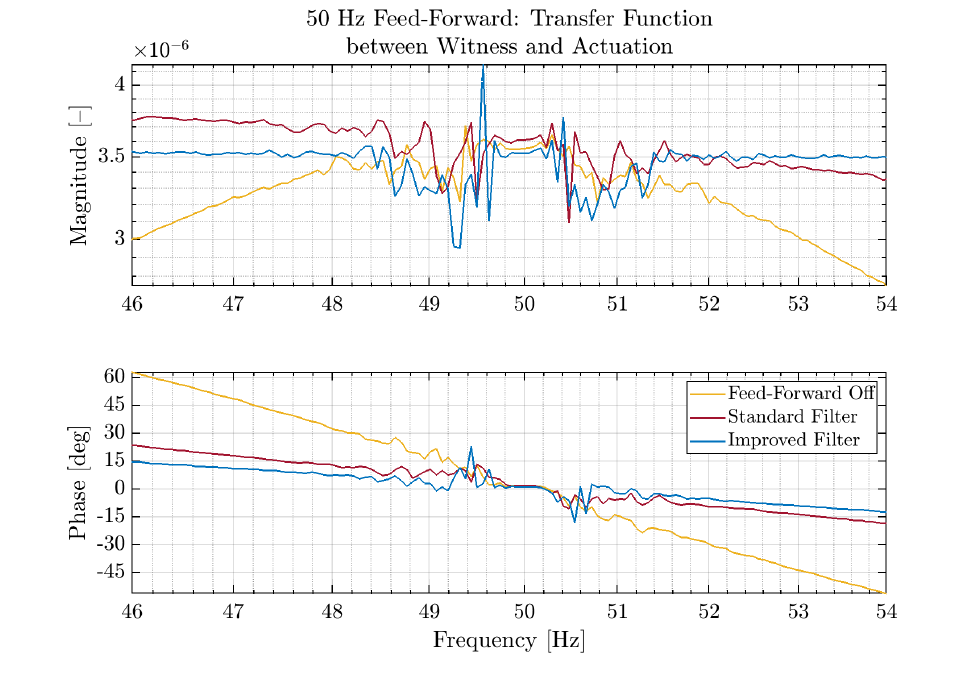
Figure 6. 50Hz Feed-Forward: transfer function between witness and actuation. It can be observed how in the initial transfer function, with the feed-forward not engaged (yellow trace), the actuation could reproduce the information from the witness channel only at 50Hz; a progressively better filtering of the witness signal (red and blue traces) brought to a flatter transfer function, minimizing the risk of reintroducing noise and allowing a broadening of the bandwidth of the feed-forward